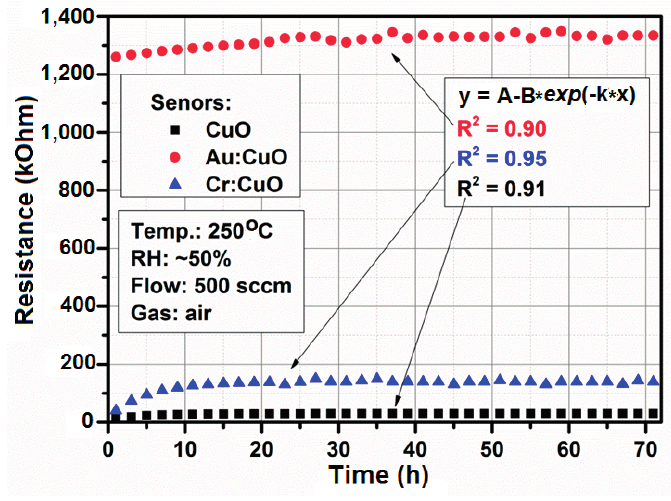
Figure 16. The baseline resistance change in time for the CuO-, Au:CuO- and Cr:CuO-based sensors for typical working